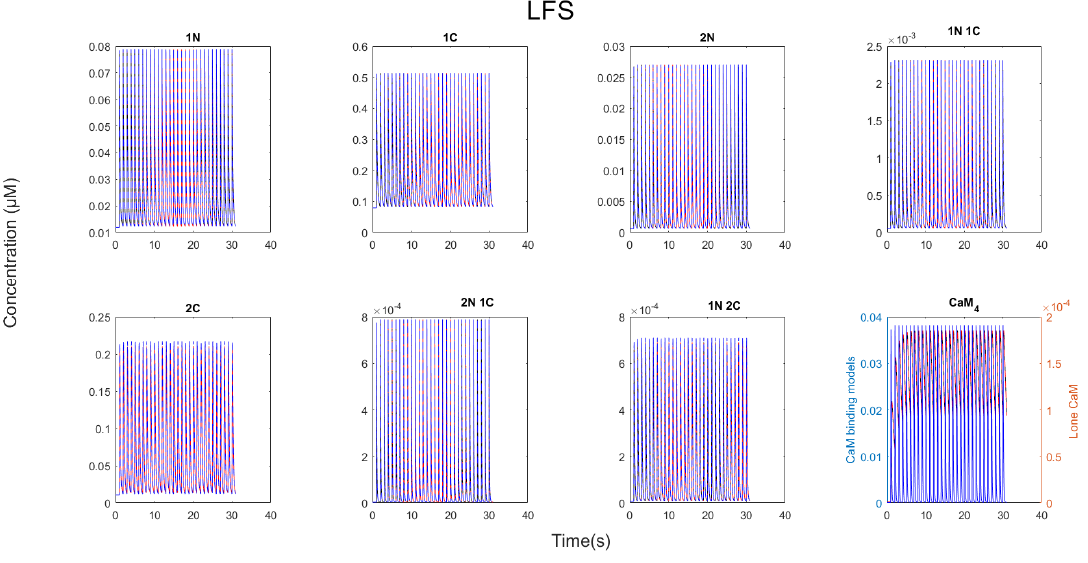
Figure 8. CaM states when LFS was run for 30 pulses at 1 pulse per second. There were no differences between partially bound states between the full CaM system and the non ‐ fully bound CaM system.